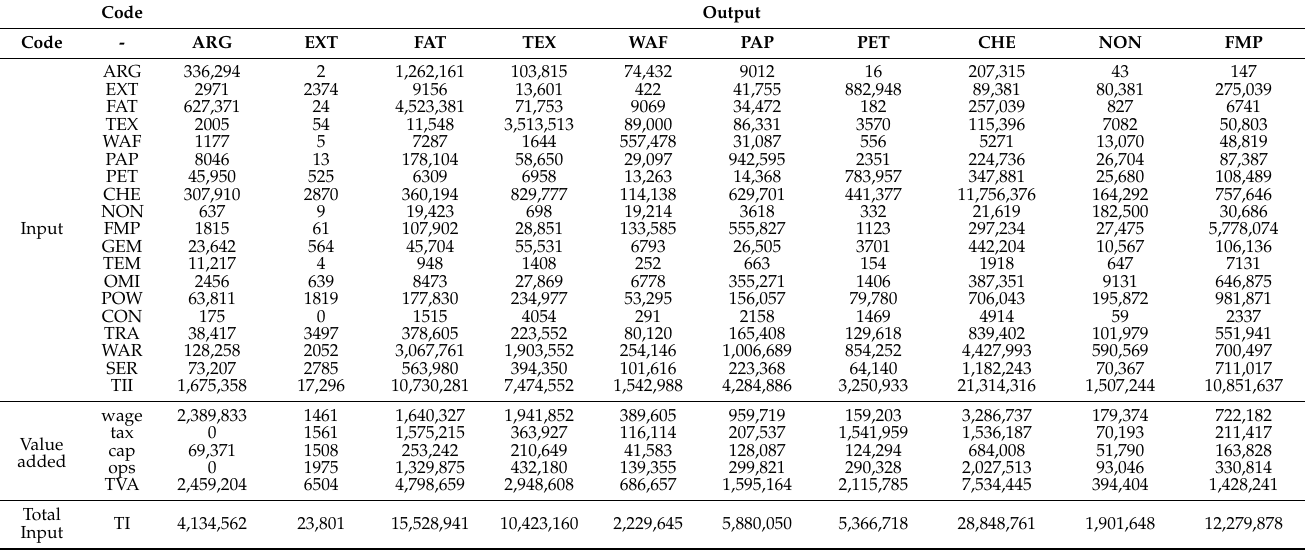
Table A7. Guangzhou input-output Table 2015 (Unit: 104 Yuan) (data from the author’s survey and